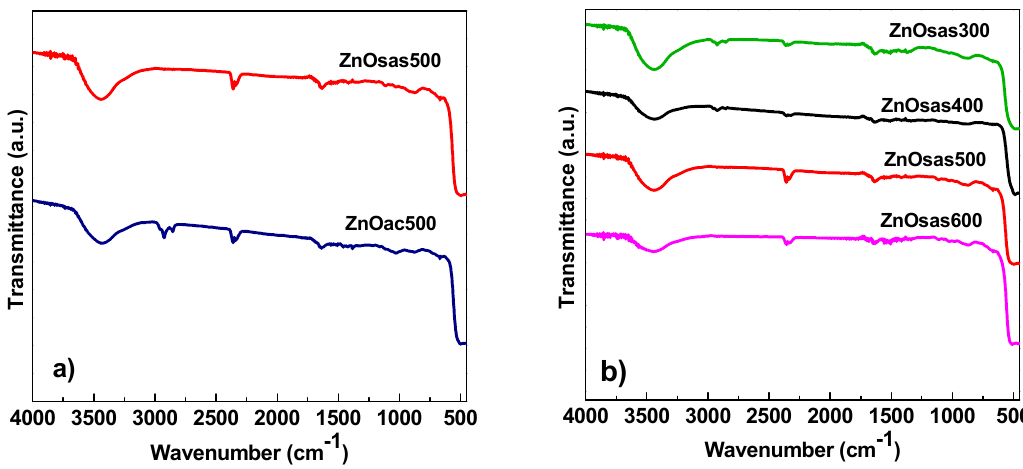
Figure 4. Fourier transform infrared (FT-IR) spectra of ( a ) zinc oxide (ZnO) from supercritical antisolvent (SAS) zinc acetate (ZnAc) nanoparticles calcined at 500 °C and ZnO from unprocessed ZnAc calcined at 500 °C; ( b ) ZnO from SAS ZnAc nanoparticles calcined at 300, 400, 500, and 600 °C.